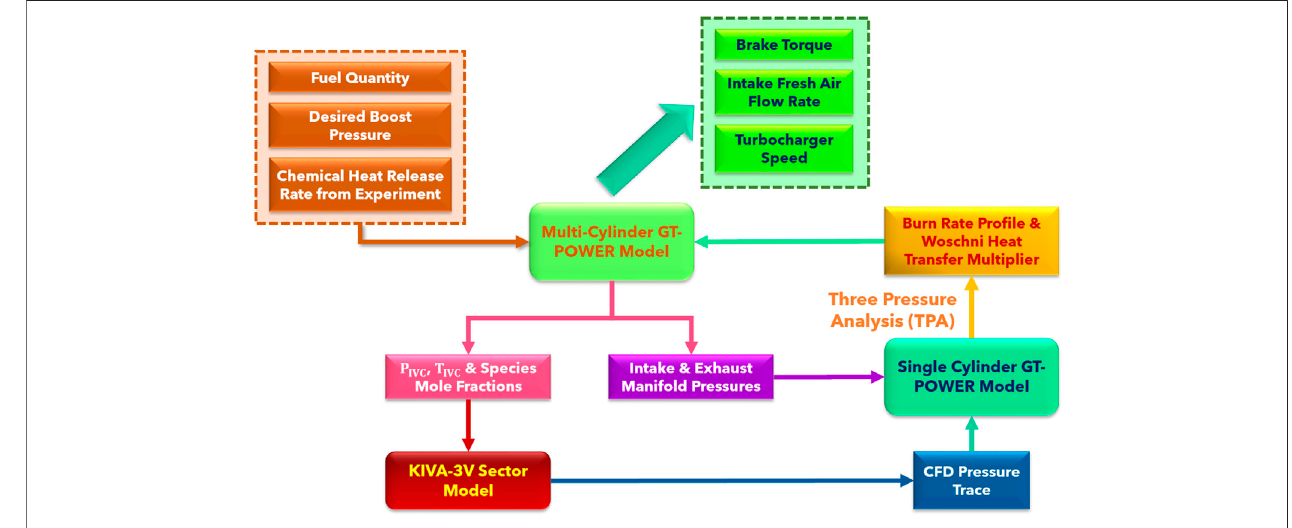
FIGURE 3 | Model calibration methodology.